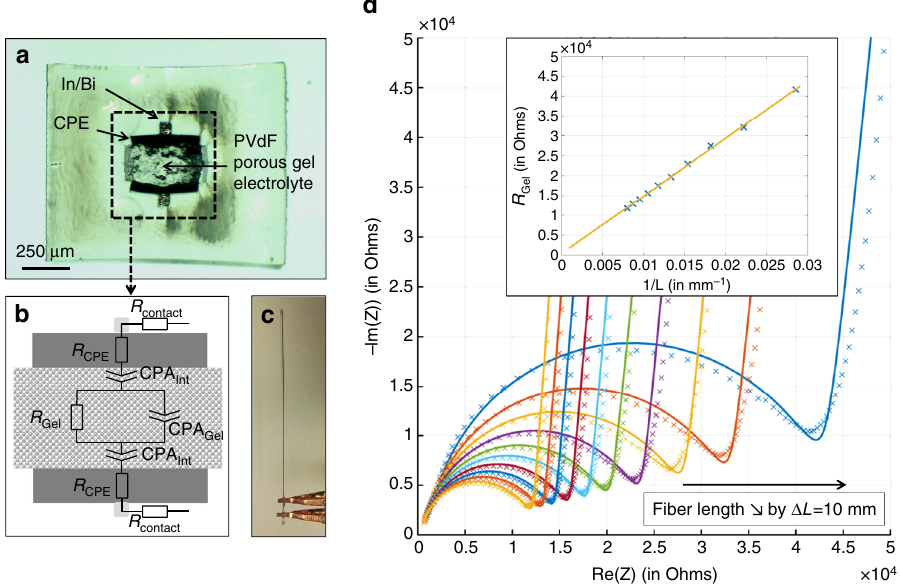
Fig. 4 Transverse ionic transport measurement through impedance spectroscopy of ionic liquid- fi lled porous core fi bers. ( a ) Optical micrograph of fi ber sample displaying a porous core fi lled with a 10 − 3 m PYR13TFSI in propylene carbonate solution, adjacent CPEs and contiguous Bi-In metal buses. ( b ) Simple equivalent circuit expected from fi ber samples. CPA refer to Constant Phase Angle elements. ( c ) Photograph of a connected fi ber sample. ( d ) Impedance spectra for a fi ber between 12 and 1 cm, sequentially cut by 10 mm decrements. Solid lines are fi ttings results with equivalent circuit. The inset shows the dependence of R Gel as a function of the inverse-length of the fi ber and shows a linear relationship, as expected from